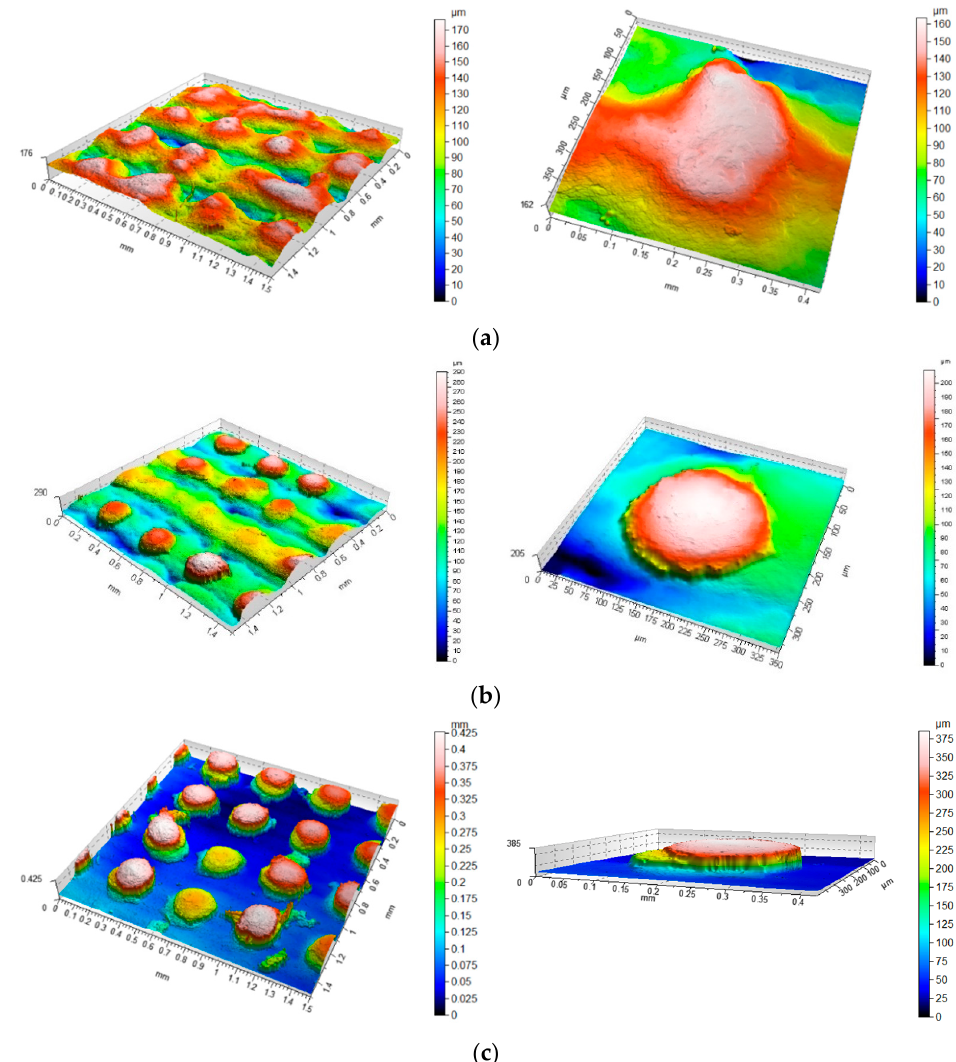
Figure 5. An isometric view of the surface of sample 1 together with a view of an example bump at an angle of ( a ) 0° ( b ) 45° ( c ) 90°; scales should be analysed carefully.